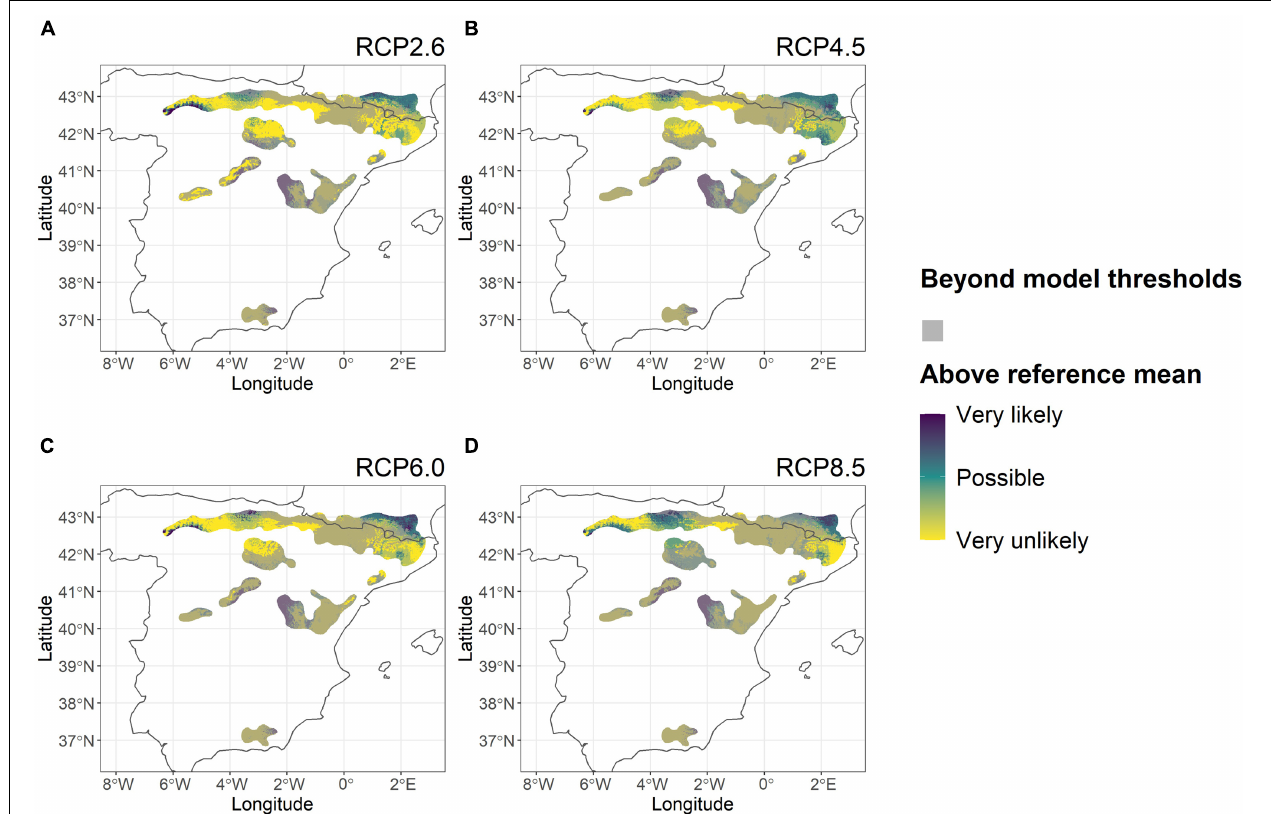
FIGURE 4 | Likelihood of tree height increase for Scots pine within its distribution range in Spain under future climate scenarios in comparison to that of the reference period (1961–1990). The probability was assessed as the agreement among five GCMs within each RCPs on tree height increase based on model predictions for RCPs 2.6 (A) , 4.5 (B) , 6.0 (C) , and 8.5 (D) . All locations where environmental variables exceeded those of the model data range according to at least three GCMs have been dimmed in semi-transparent